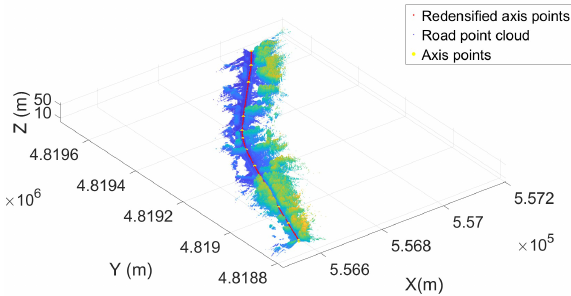
Figure 5. Redensified axis process (red points).